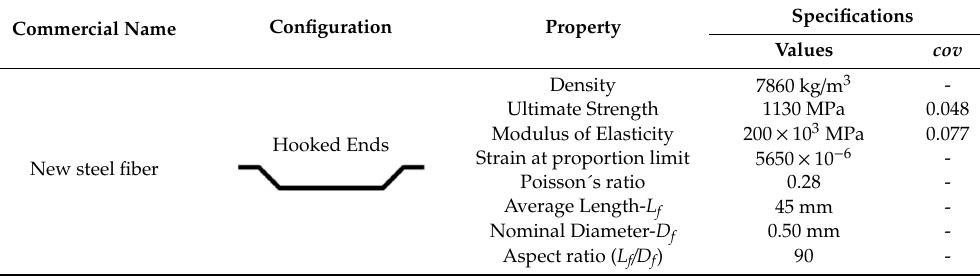
Table 2. Properties of steel fiber.